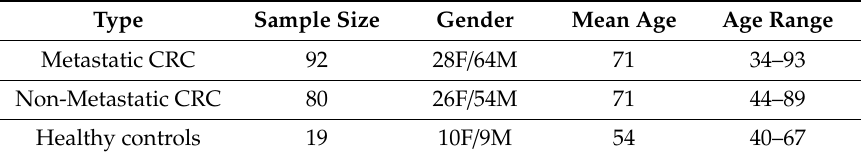
Table 1. Characteristics of the groups of patients taking part in the study.